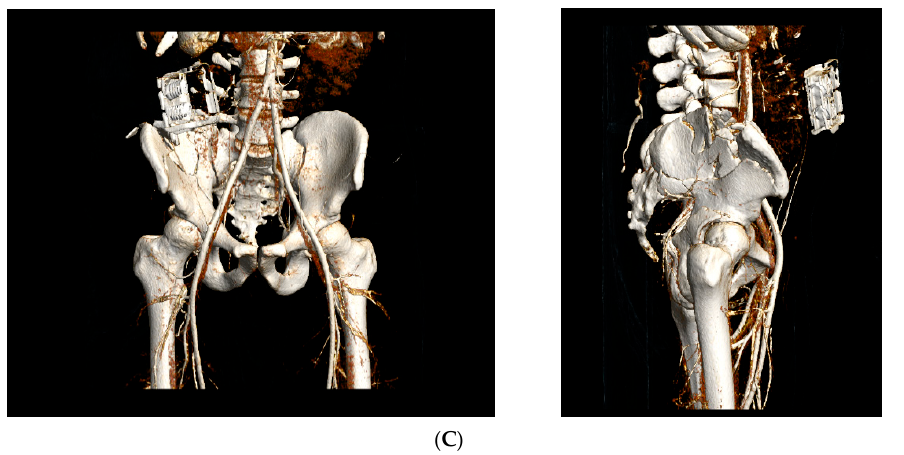
Figure 1. Pelvic circumferential compression device (PCCD) positioning (example of the SAM Pelvic-sling II). (A) Correct positioning of a PCCD at the level of the trochanters; (B) Acceptable positioning of a PCCD with partial coverage of the trochanters; (C) Incorrect positioning of a PCCD without any covering of the trochanters.